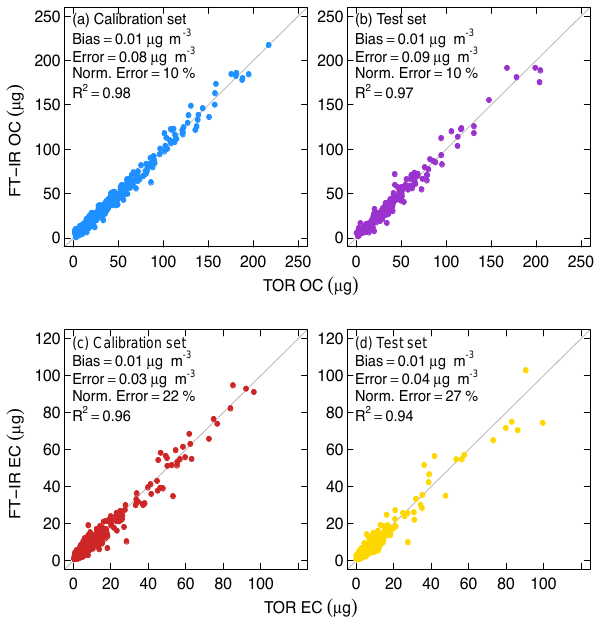
Figure 9. Predicted FT-IR OC vs. measured TOR OC using smooth- ing splines-corrected spectra for (a) calibration set ( n = 517) and (b) test set ( n = 268). Predicted FT-IR EC vs. measured TOR EC using smoothing splines-corrected spectra for (c) the calibration set ( n = 501) and (d) the test set ( n =